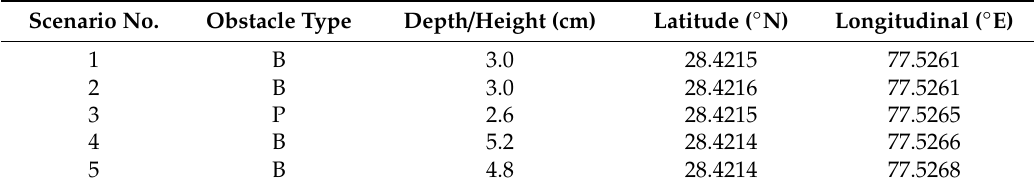
Table 3. Information of pothole (P) and bumps (B) collected during real-time testing using an ultrasonic sensor with dynamic time warping (DTW) for the R1 test site. Scenario No.